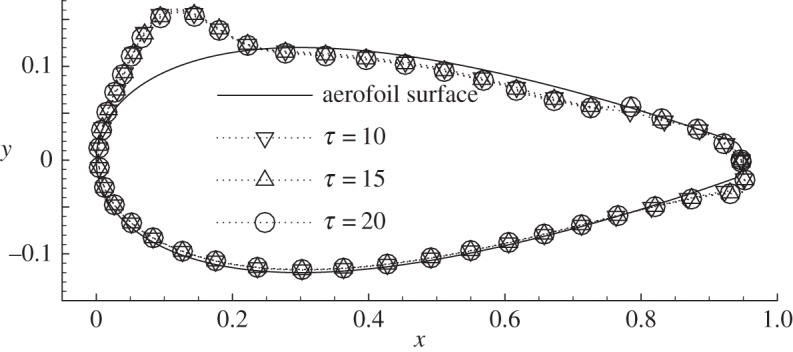
Convergence of the sensitivity of the drag to the normal control at Re=5000, α=10° and various final times τ. The sensitivity has been normalized to have b-norm 0.02 and is plotted based on the aerofoil. The surface-normal deviation of the sensitivity curves from the aerofoil denotes the local magnitude of the sensitivity. A deviation to the aerofoil (in direction n) represents positive sensitivity and vice versa. This convention will be used in all the following plots of distributions of variables along the aerofoil.